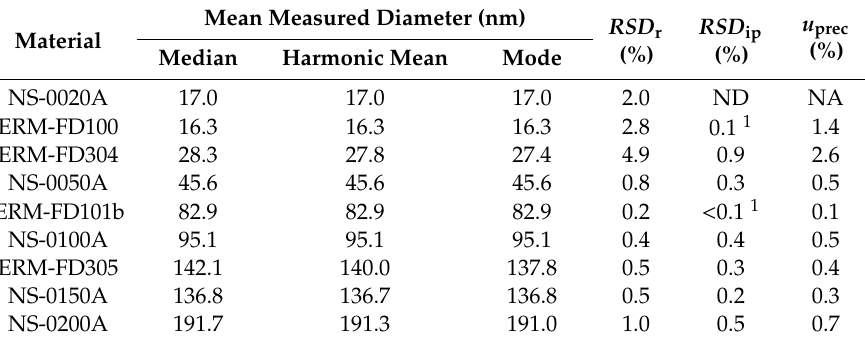
Table 4. Results for repeatability and intermediate precision